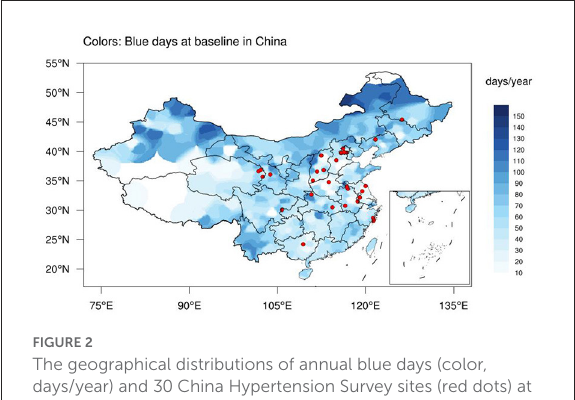
FIGURE2 The geographical distributions of annual blue days (color, days/year) and 30 China Hypertension Survey sites (red dots) at baseline (2012–2015) in China.